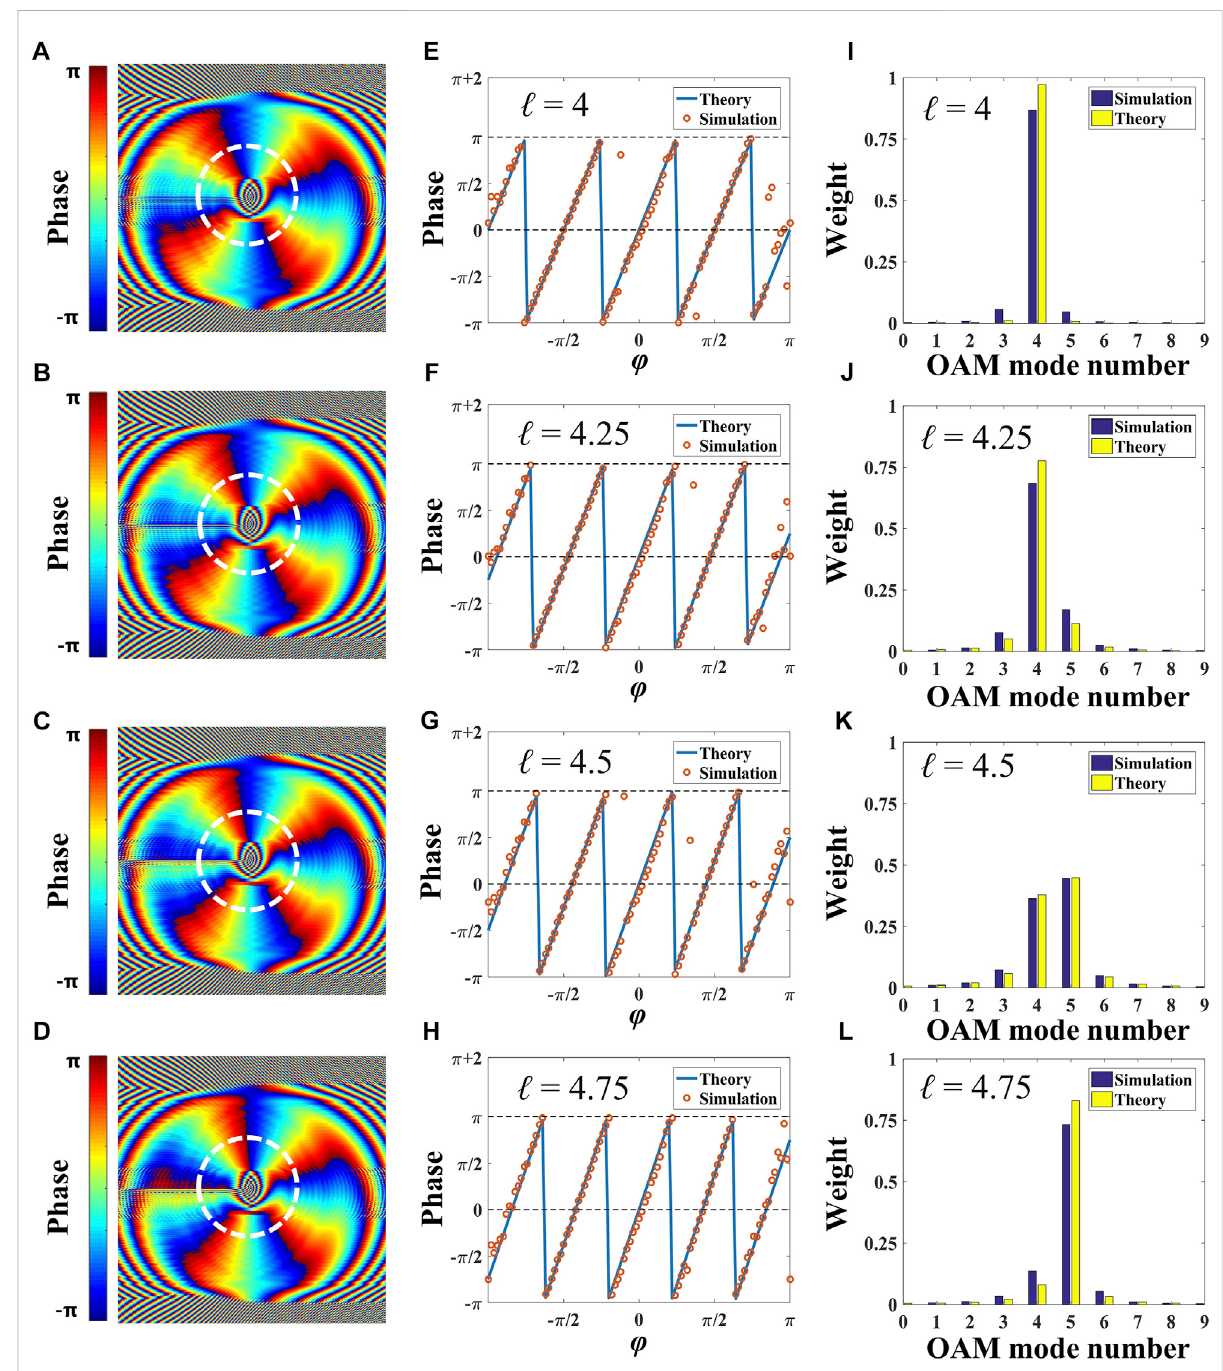
FIGURE 5 Propertiesofthegeneratedfraction-ordervortices. (A – D) Phasedistributions. (E – H) Phasevariationsalongwiththecirclesin (A – D) . (I – L) OAM spectrum corresponding to (A – D)